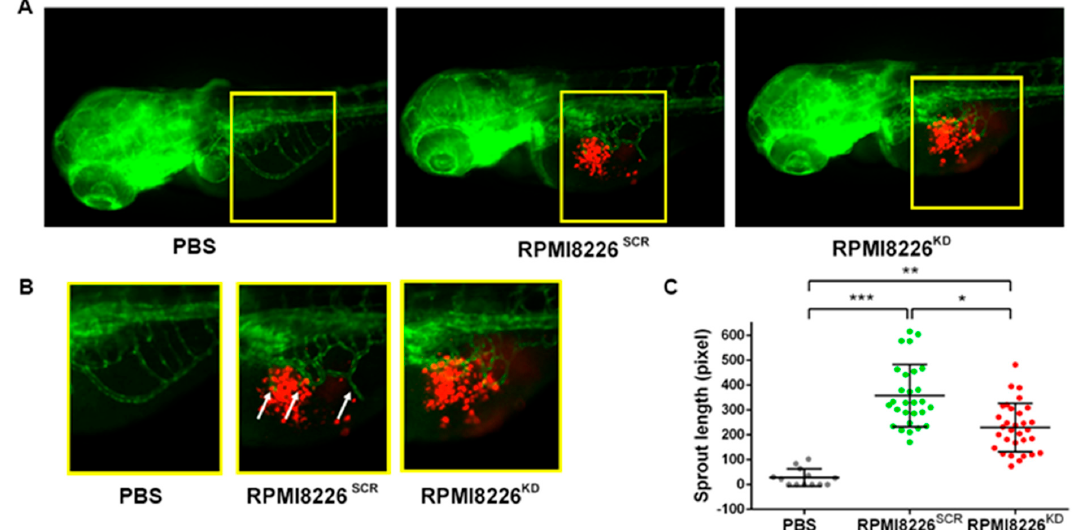
Figure 4. Zebrafish embryo in vivo model to evaluate tumor-induced angiogenesis in relation to Jagged expression in HMCLs. ( A ) Representative images of Tg(fli1a:EGFP) y1 zebrafish embryos with GFP expressing vessels (green) and RPMI8226 SCR or RPMI8226 KD stained with CM-Dil fluorescent dye (red). Epifluorescence images were acquired with a Leica DM 5500B microscope equipped with a DC480 camera. ( B ) Inset of sprouting vessels from SIV in zebrafish embryos 24 hpi; white arrows indicate angiogenic sprouts. ( C ) Quantification of endothelial sprouts from the SIV plexus was performed in 24 h post-injection (hpi) zebrafish embryos injected with RPMI8226 SCR (N = 24) and RPMI8226 KD cells (N = 31) using ImageJ software (National Institutes of Health, USA). Statistical analysis was carried out by one-way ANOVA with Tukey post hoc tests of three independent experiments; * is for p ≤ 0.05; ** is for p ≤ 0.01; *** is for p ≤ 0.001.